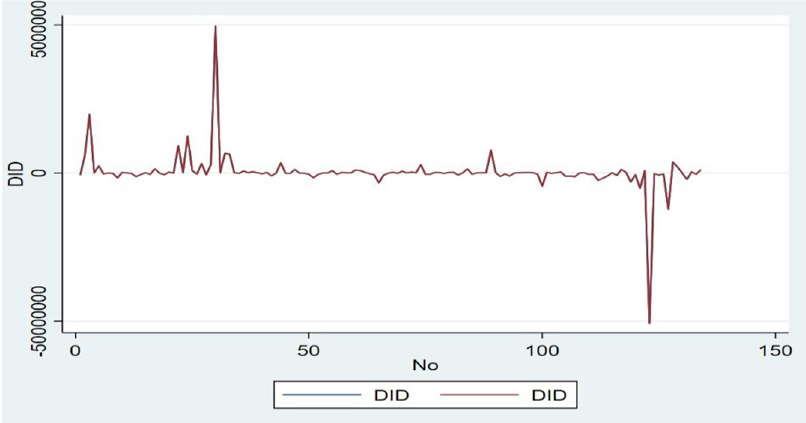
Fig. 9 The data and logarithms fi rst-difference.